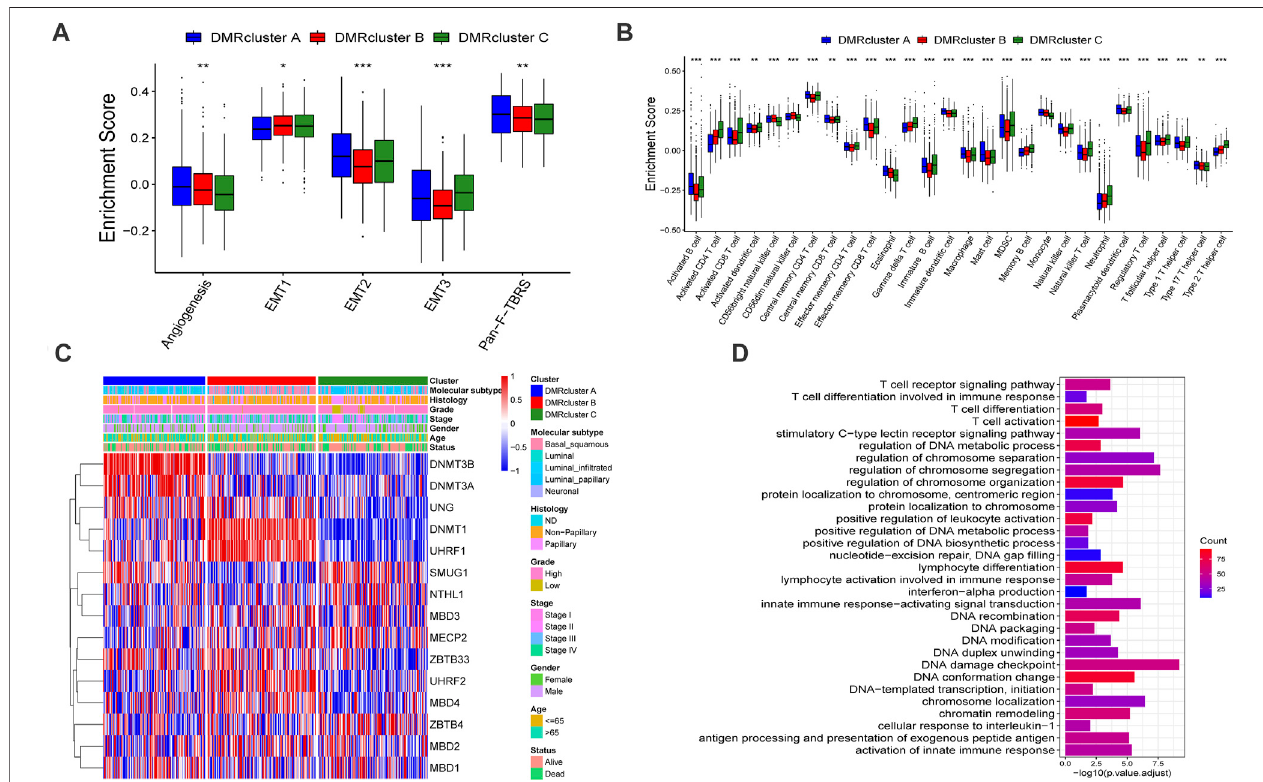
FIGURE 3 | Tumor microenvironment characteristics and transcriptome pro fi le in three DNA methylation modi fi cation modes. (A) stromal activation pathways among three different DNA methylation modi fi cation modes include EMT, angiogenesis and Pan-F-TBRS. (B) The content of each tumor microenvironment immune in fi ltrating cells in three DNA methylation modi fi cation modes. The median value: black lines in boxes, the outliers: black dots out boxes. (C) The heatmap help us to observe the expression level of DNA methylation regulators among different DMRclusters (TCGA-BLCA cohort). DMRcluster subtypes, Molecular subtypes, Histology, Grade, Stage, Gender, Age and Survival status were used as patient annotations. Red represented high expression level of DNA methylation regulators and bluerepresentedlowexpressionlevel. (D) FunctionalannotationforDNAmethylation-relatedgenes.Redrepresentedmoreenrichedgenesandbluerepresentedasmall number of enriched